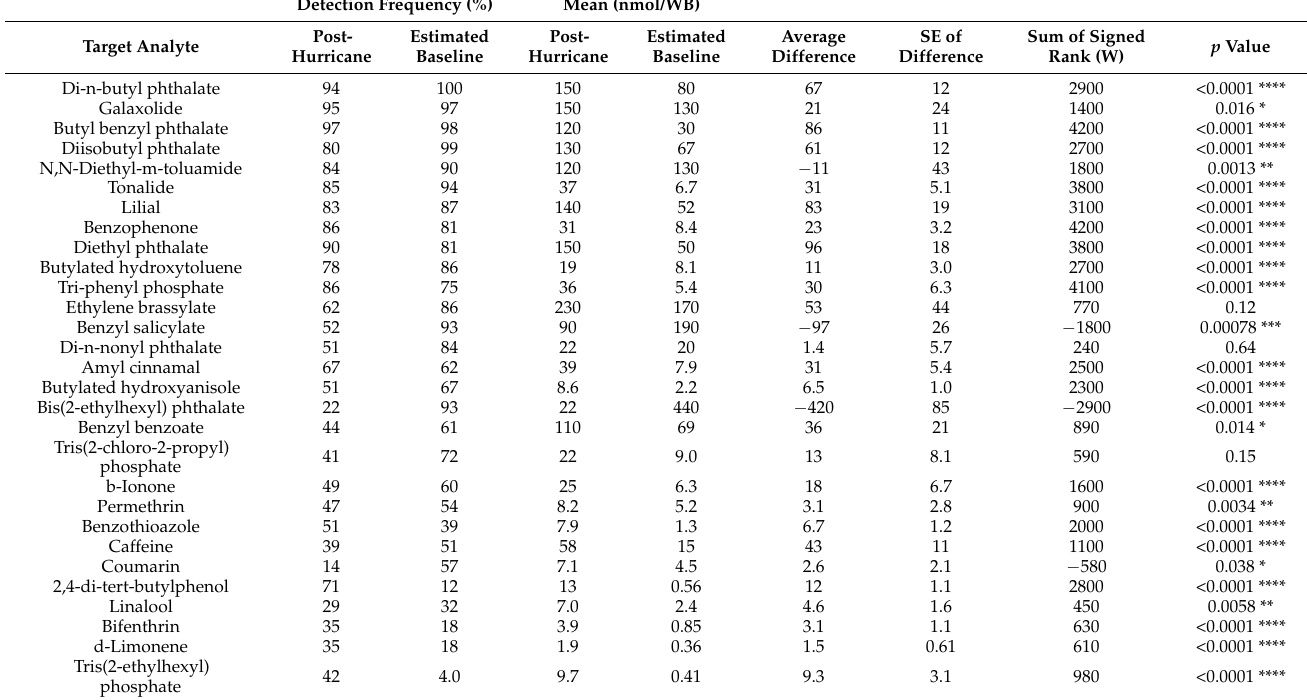
Table 1. Summary statistics including results from Wilcoxon matched-pairs signed rank tests for all analytes detected in the 1500 screening method detected in greater than 30% of the study pop- ulation in at least one timepoint. The PAHs anthracene, 1-methylnaphthalene, naphthalene, and 2-methylphenanthrene were all excluded due to redundancy with the 63 PAH method and are discussed elsewhere. Differences were calculated by subtracting individual estimated baseline con- centrations from the paired post-hurricane concentration. Analytes are ordered in decreasing overall detection frequency across both